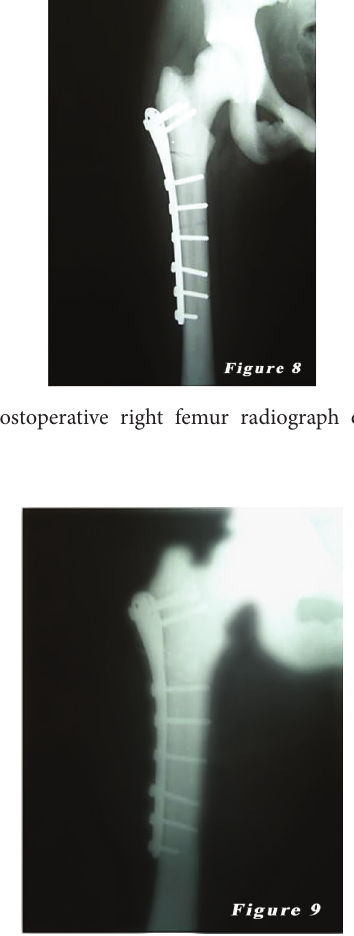
Figure 9: Her last right femur radiography. It looks like fracture